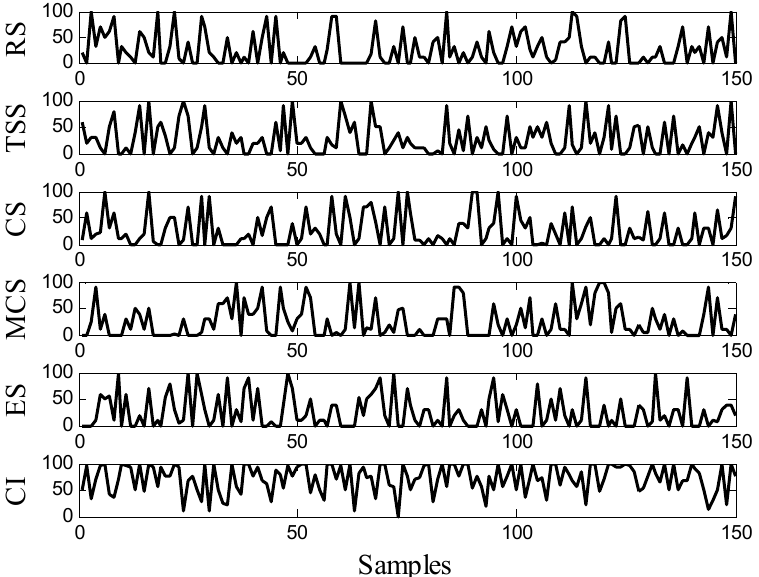
Figure 8. Input and output datasets used to train and test ANN.